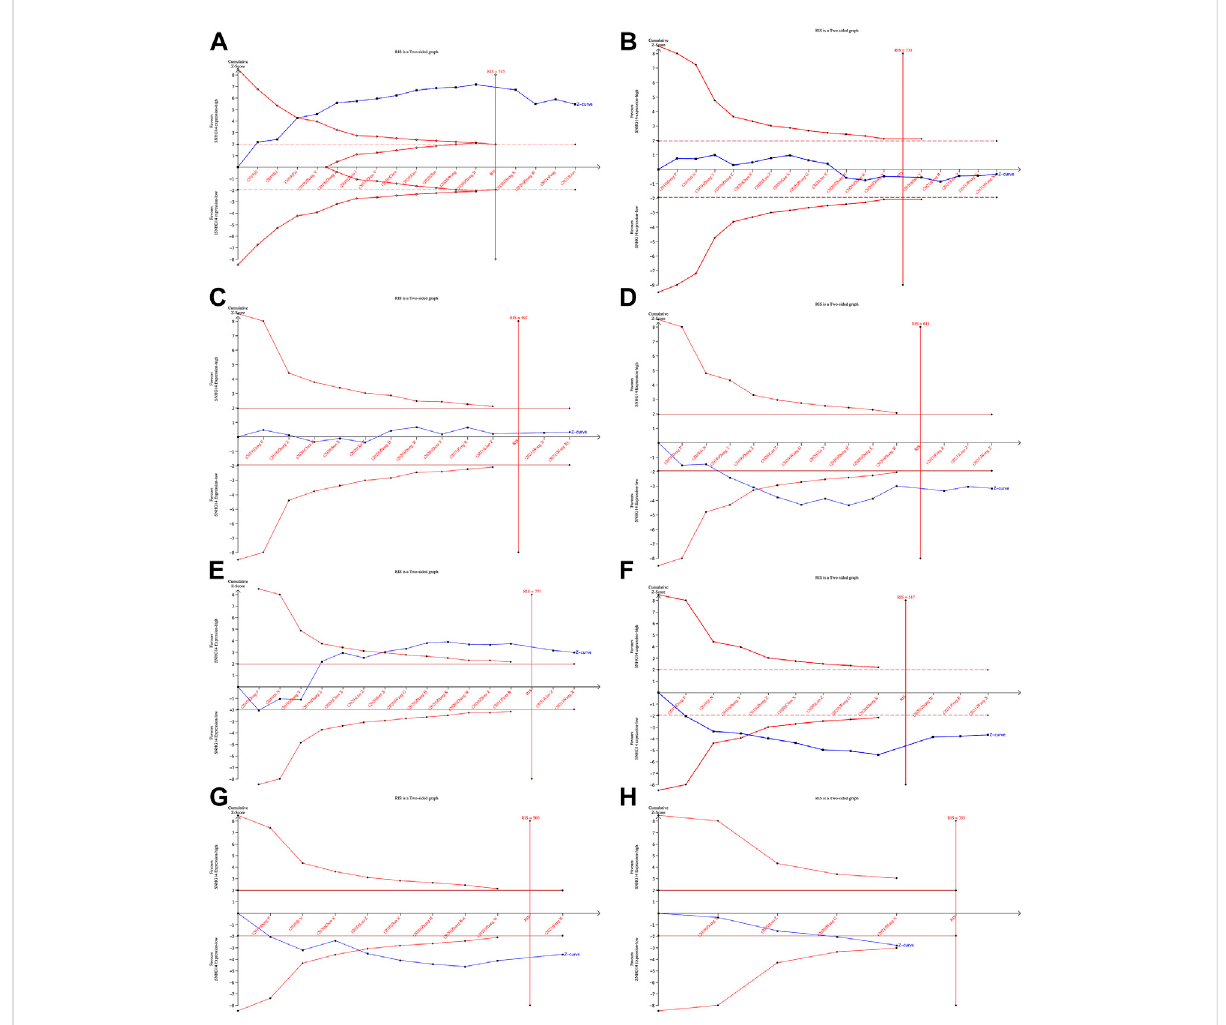
FIGURE 6 Results of TSA:OS (A) , Age (B) , Gender (C) , Tumor size (D) , TNM staging (E) , Lymph node metastasis (F) , Differentiation grade (G) , Distant metastasis (H)